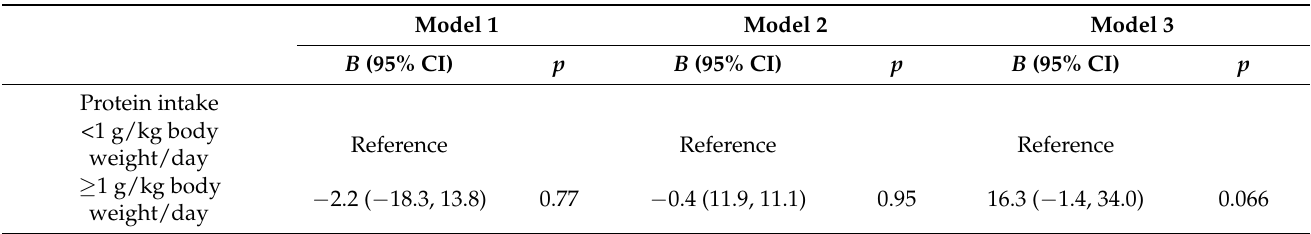
Table 3. Multiple linear regression of probing depth sites ≥ 4 mm after non-surgical periodontal therapy in patients who smoked 1